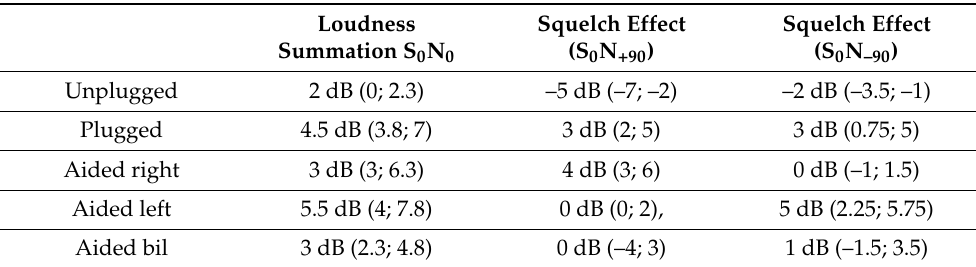
Table 2. Median SNR 50 values (interquartile range) at loudness summation (S 0 N 0 ) and squelch effect (S 0 N +90 and S 0 N − 90 ) testing.